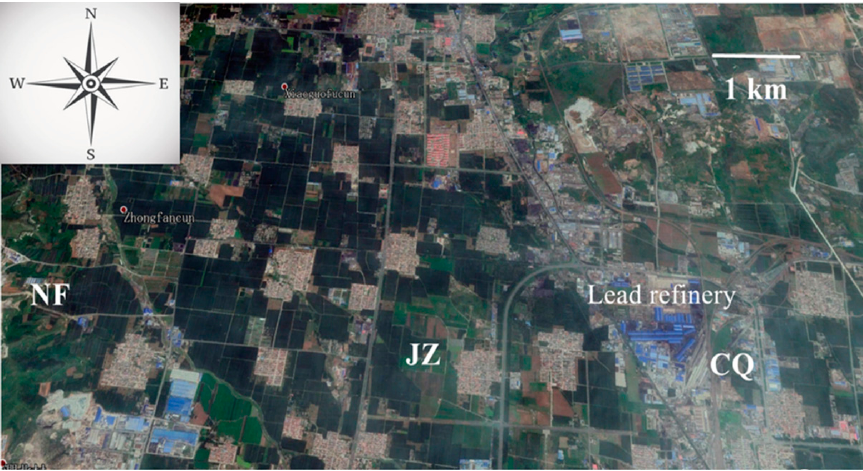
Figure 1. Sample sites of water spinach rhizosphere soil.